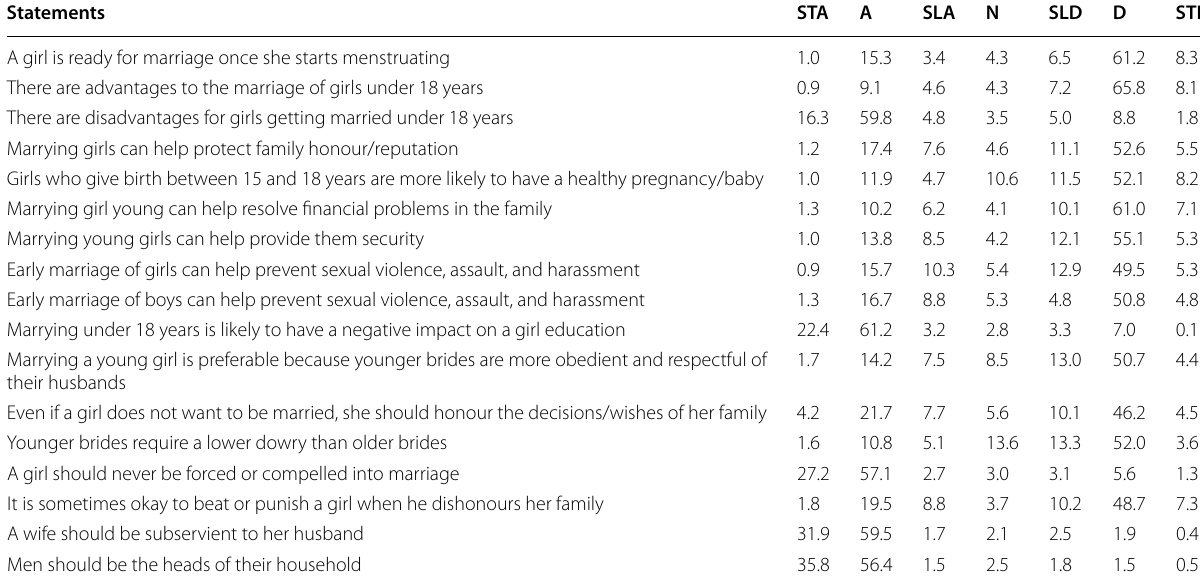
Table 4 Perceptions on child marriage acceptability (n